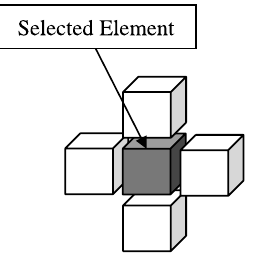
Fig. 2. Selected element and its neighbours.